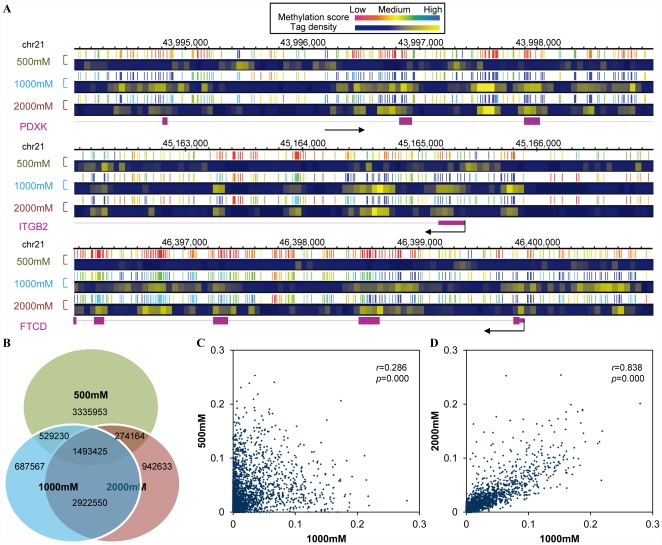
Correlation of CpG methylation score of different salt concentrations.A. Three representative regions on chromosome 21 show the methylation sites captured by 500 mM elution are distinct to those from 1000 mM and 2000 mM elution. B. A Venn diagram shows the overlap of top 20% predicted methylated CpG sites in three different elutions. 1000 mM and 2000 mM elution has an overlap of nearly 80% overlap, while only 35.9% overlap between 500 mM and 1000 mM is observed. C. and D. show the correlation of methylation probability of individual CpG site under different condition. C. shows the low correlation (r = 0.286, p = 0.000) between 500 mM and 1000 mM. D. shows the high correlation (r = 0.838, p = 0.000) between 1000 mM and 2000 mM.